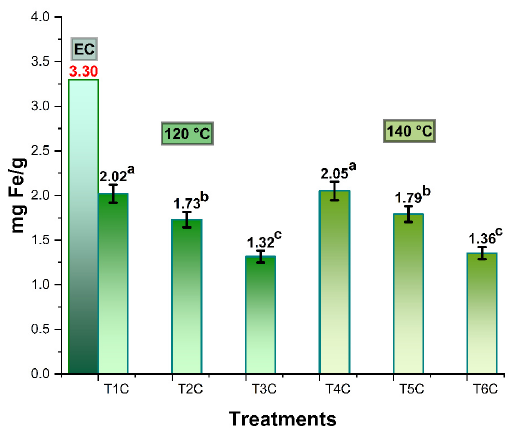
Figure 3. Iron content in spray-dried erythrocytes (EC), encapsulated a 120 °C (T1C, T2C y T3C)